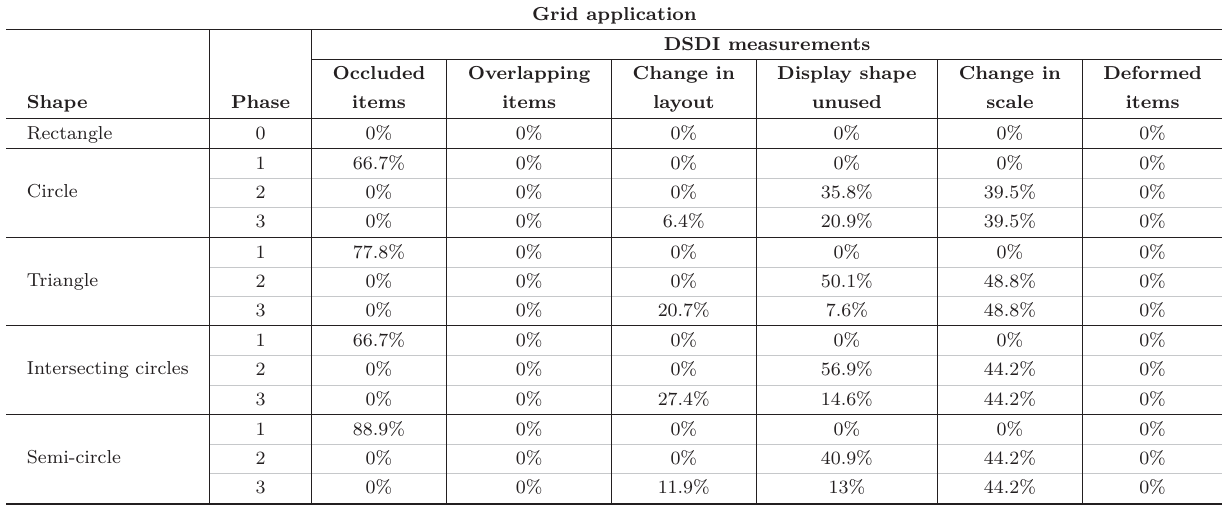
Table 1 DSDI measurements from the study in SynergyNet ’s Grid